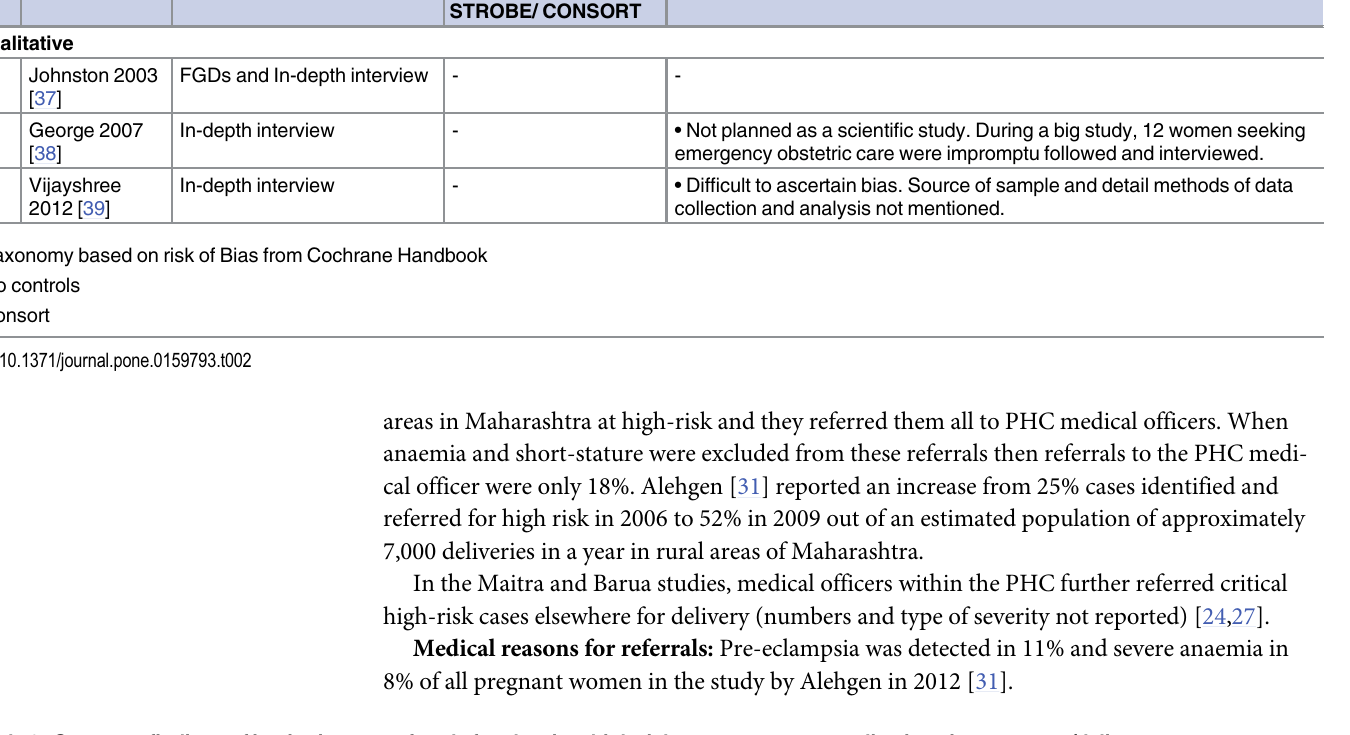
Table 3. Summary findings of institution out-referrals for abortion, high-risk pregnancy, or complications in pregnancy/delivery. Out-referrals for